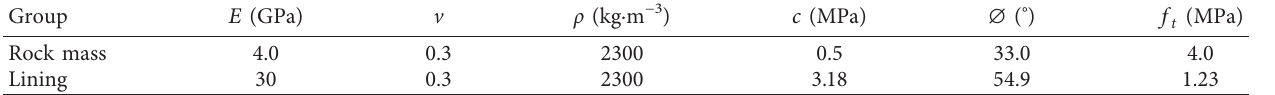
Table 1: Physical and mechanical parameters used in the numerical